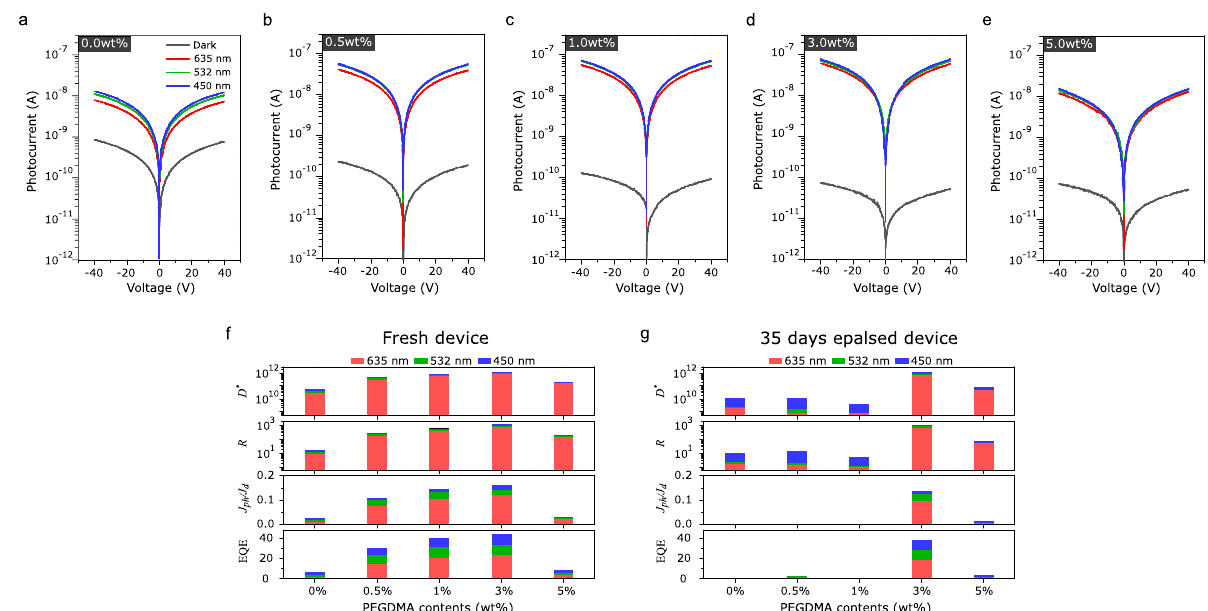
Fig. 4 The electrical properties of Au/ γ -CsPbI3 (0, 0.5, 1, 3, and 5 wt% PEGDMA)/Au photoresistors under irradiation of various LED light sources. a – e Photoresponse I – V characteristics of photoresistors including fresh γ -CsPbI 3 (0, 0.5, 1, 3, and 5wt% PEGDMA), under irradiation of 0.4 mWcm − 2 of red (635 nm), green (532nm), and blue (450 nm) LED light sources. f , g The comparison of additional optical response parameters between as-prepared and after 35 days of Au/ γ -CsPbI 3 (0, 0.5, 1, 3, and 5wt% PEGDMA)/Au photoresistors. Unit of the parameters: EQE(%), J photo / J dark , R (AW − 1 ), D*